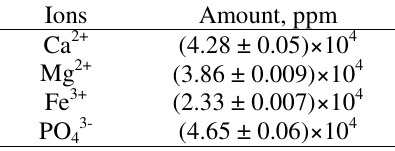
Table 2. Quantitative measure of inorganic cations and anions